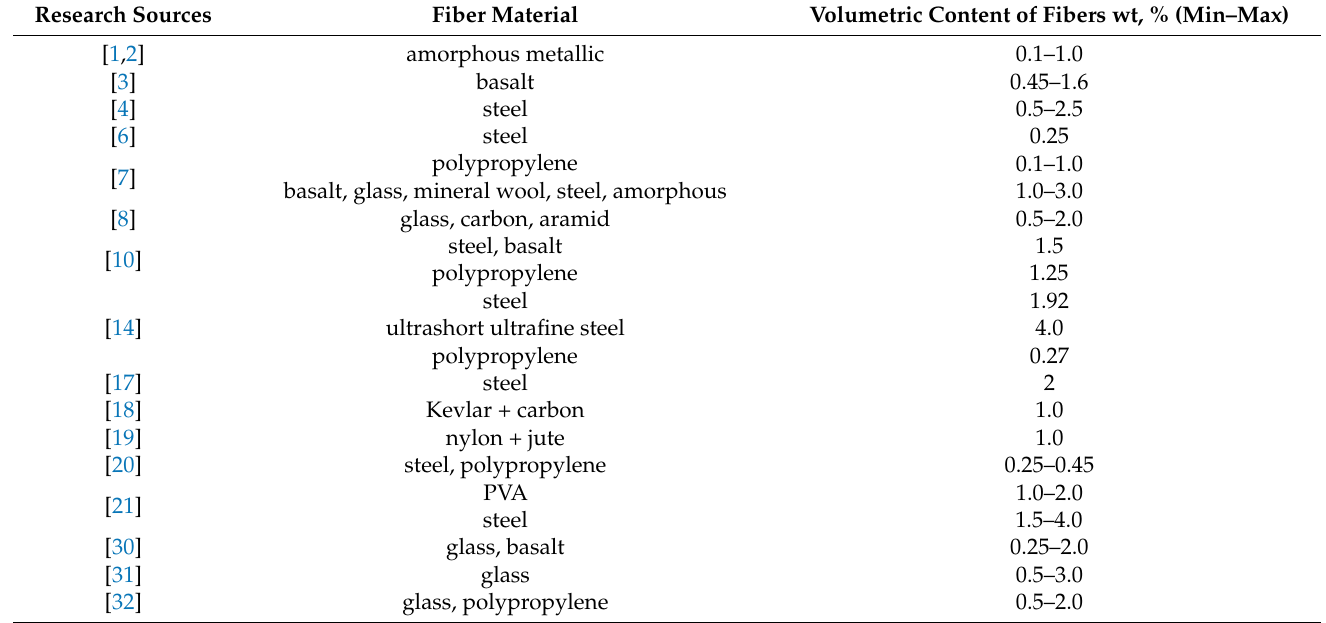
Table 4. Amount of fiber content adopted by earlier researchers.